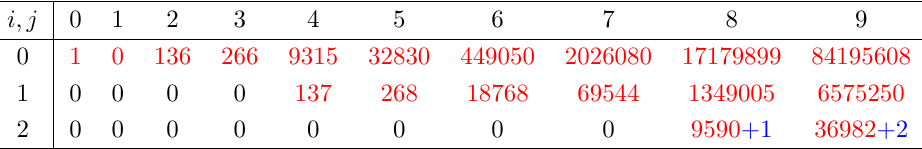
Table 18 . Series coe(cid:14)cients c E 7